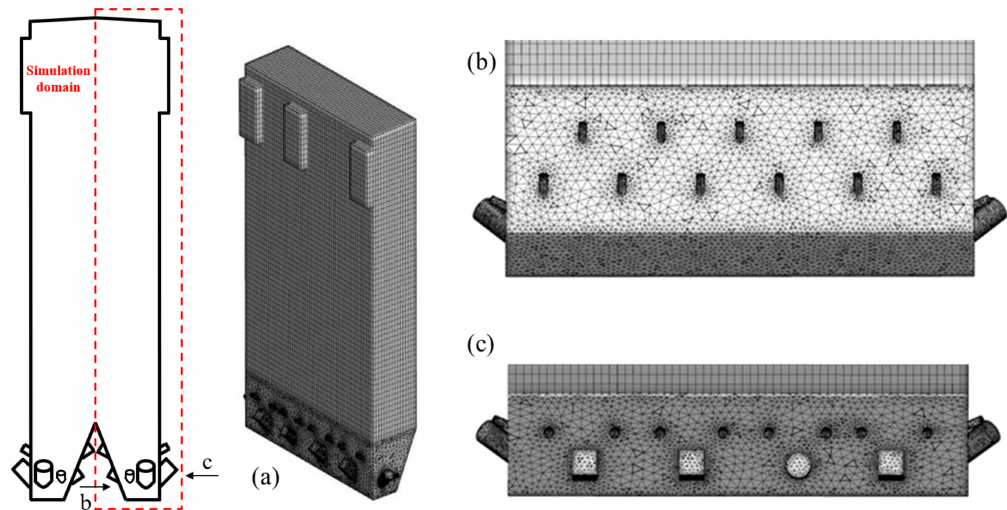
Figure 3. Grid generation of the furnace (( a )—main view; ( b )—view from the inner wall; ( c )—view from the outer